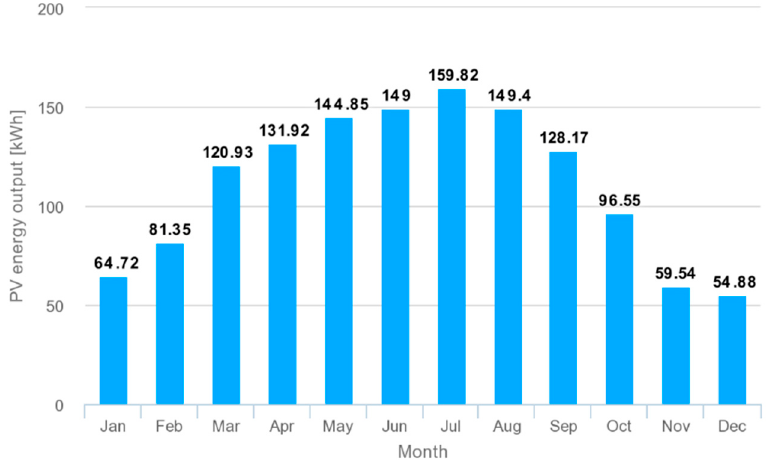
Figure 8. Monthly energy output from a fixed-angle PV system in northern Italy [35].